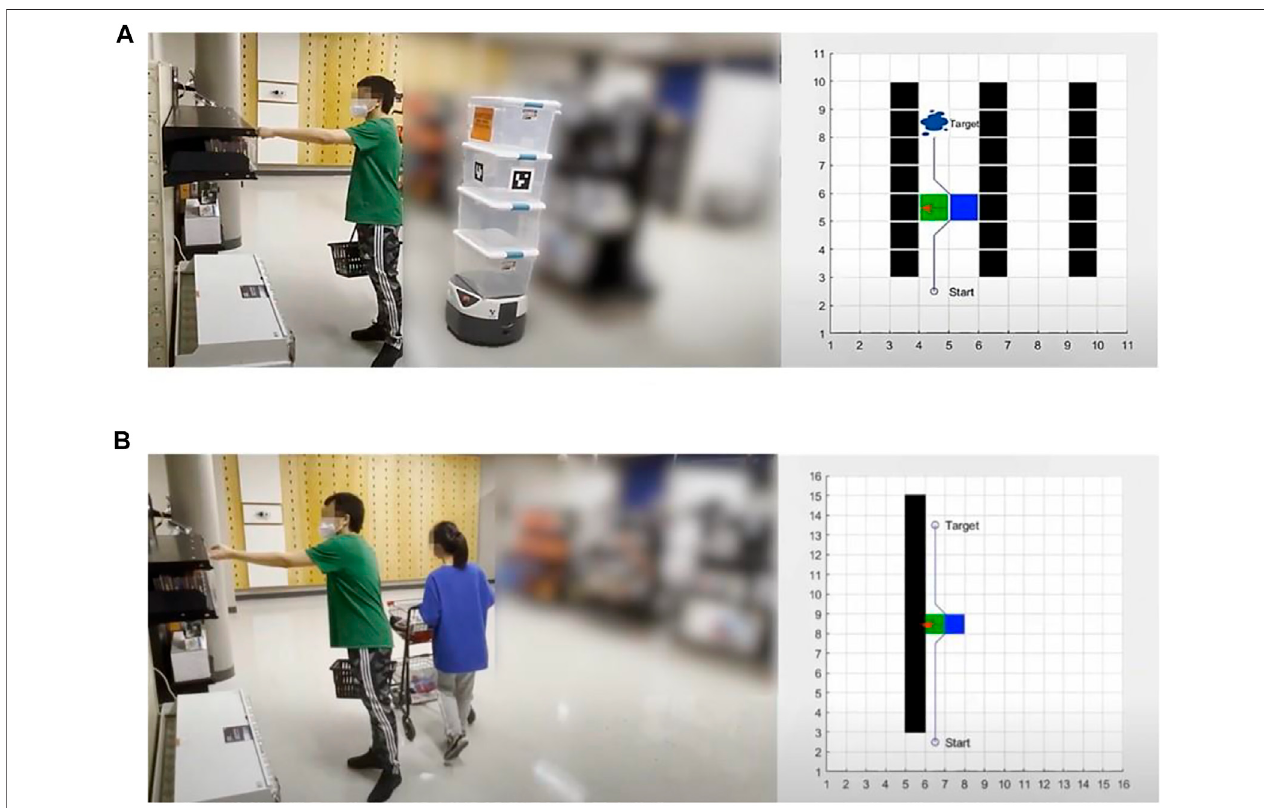
FIGURE1|(A) Ascreenshotofthevideoclipinwhichthecleaning robotpassedtheworkerinthegreenshirt (B) Ascreenshot ofthevideo clipinwhichtheworker in the green shirt was passed by another worker pushing a cart.